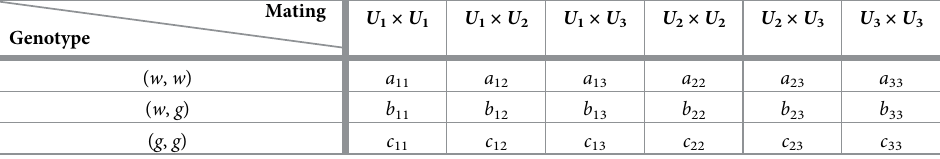
Table 1. Genotypic offspring frequencies obtained from mating wild, heterozygous and homozygous transgenic mosquitoes. Genotype